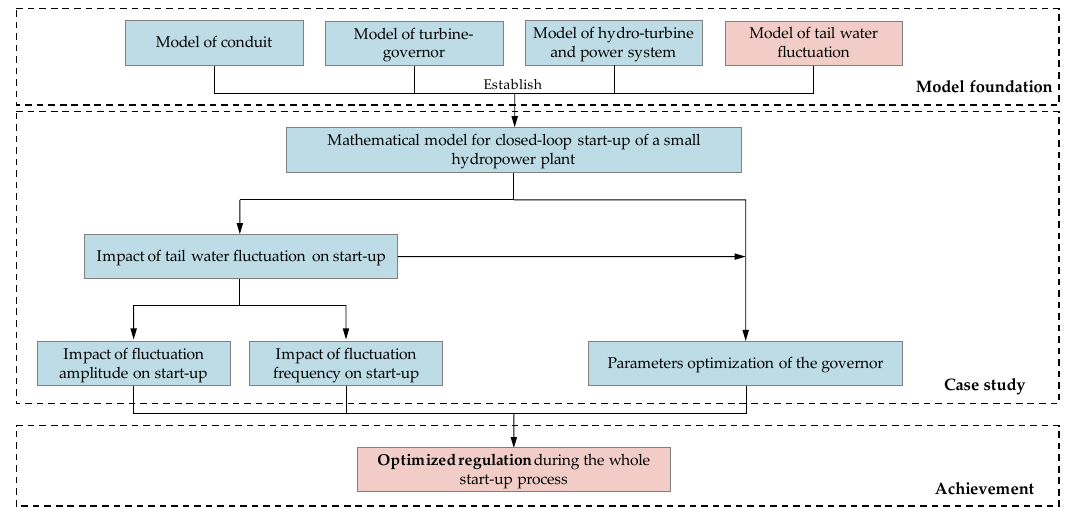
Figure 6. Technical route for the case study.